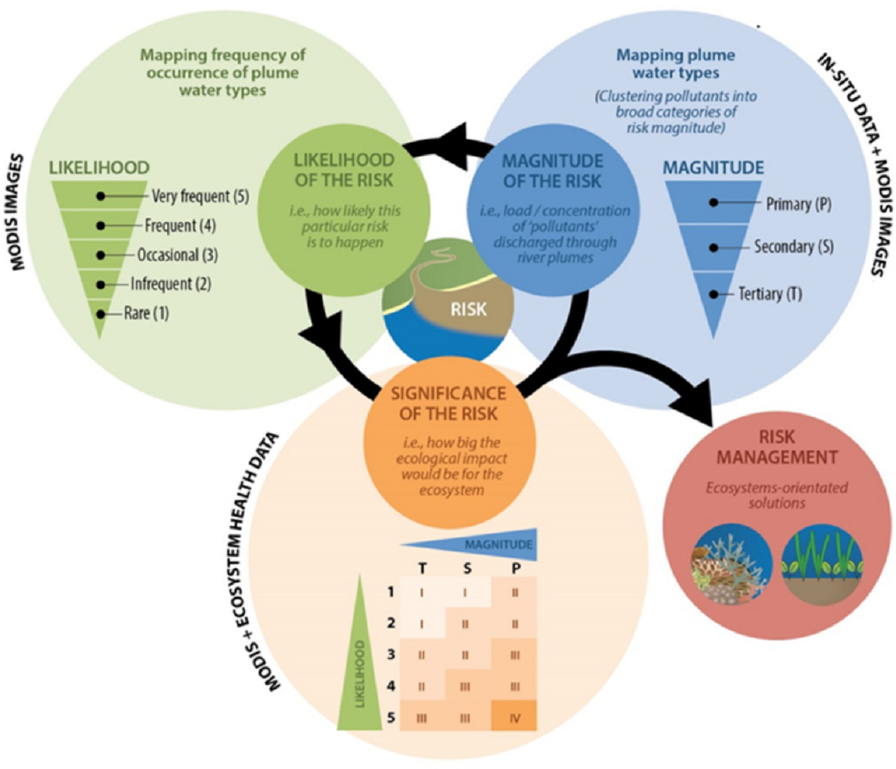
Figure 2. Conceptual scheme of the Satellite Risk Framework published in Petus et al. [16].